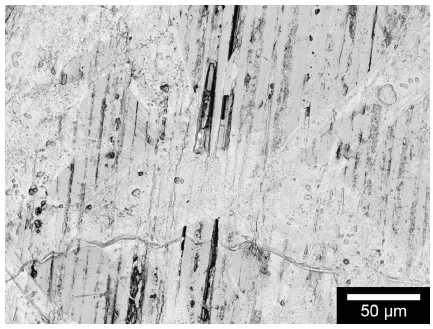
Figure 12. Laser scanning microscopic image of OB on samples. Laser image, images taken with Keyence VK-X 200, Magnification 1000×.